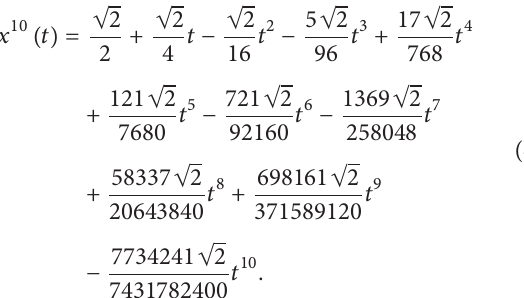
(𝑡); brown: 𝑥 2 (𝑡); initial (𝑡) exact